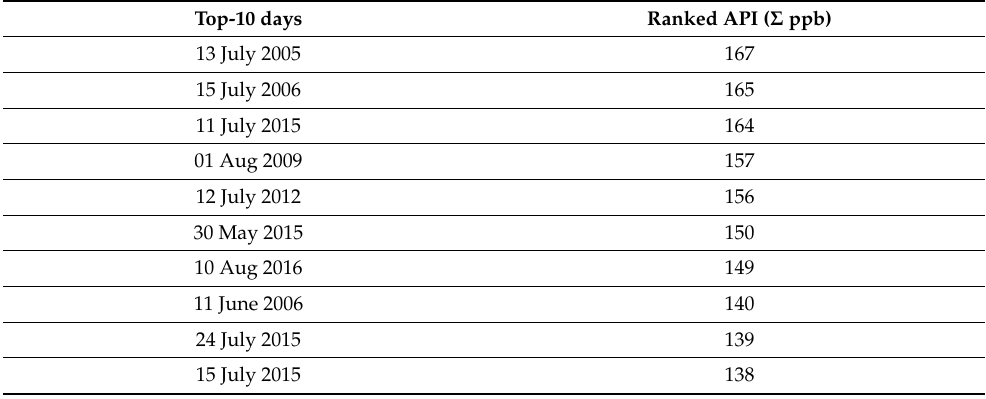
Figure 5. Composite maps of top-10 air pollution days listed in Table 4: ( a ) MERRA2 near-surface winds (m/s) with active fire icon and Durban-area: square, ( b ) surface ozone and air temperature anomalies > 1.5 C (contour). Composite east − west vertical section on 29.8 ◦ S (line in ( b )) of top-10 air pollution days: ( c ) zonal wind (shaded) & circulation (vectors), and ( d ) specific humidity (g/kg) and meridional wind (dashed contours) with topographic profile, where -V refers to airflow out of the page. Vertical motion in ( c ) is exaggerated 10-fold. Table 4. Top-10 air pollution days based on the daily cumulative API shown in Figure